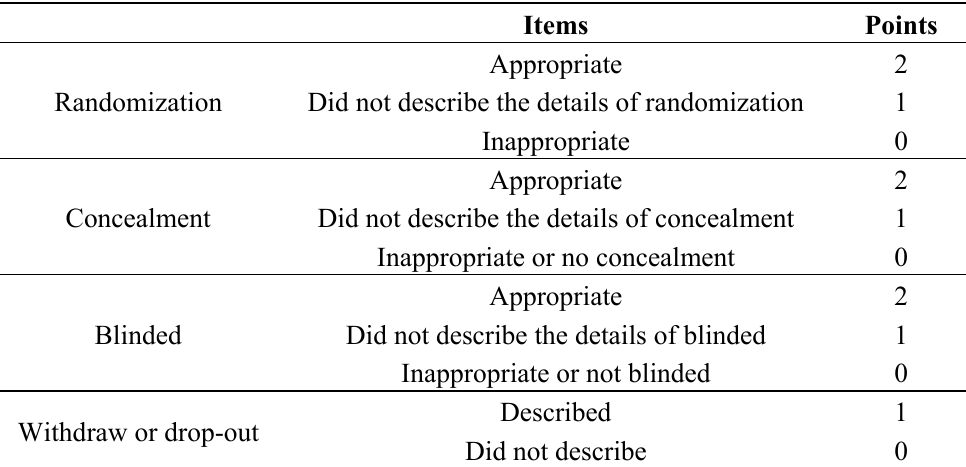
Table 2. Modified Jadad Scores